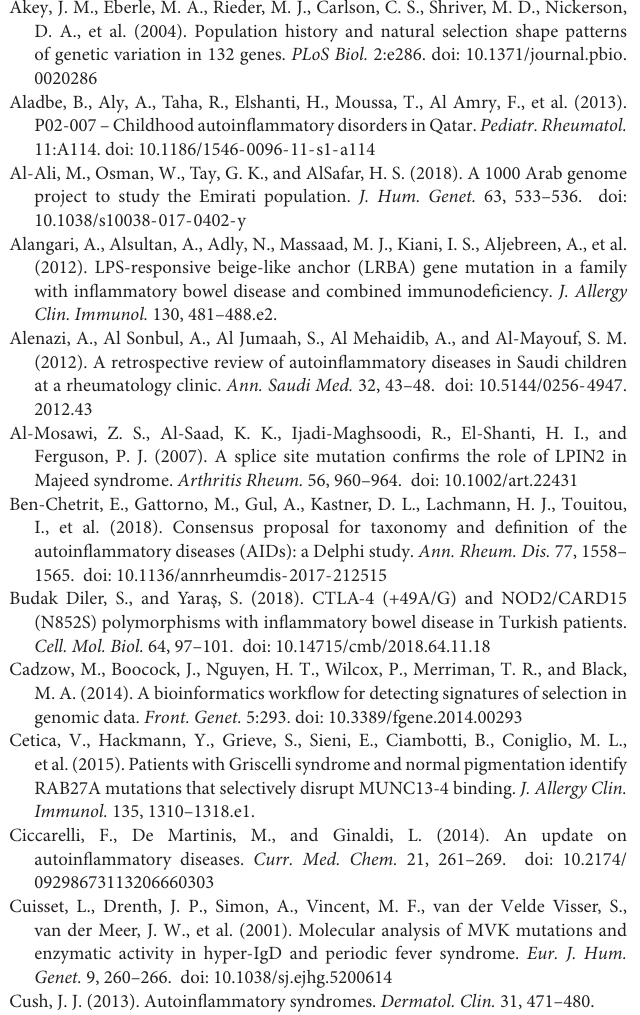
Supplementary Table 3 | The detailed variant annotation and classification based on ACMG-AMP guidelines.